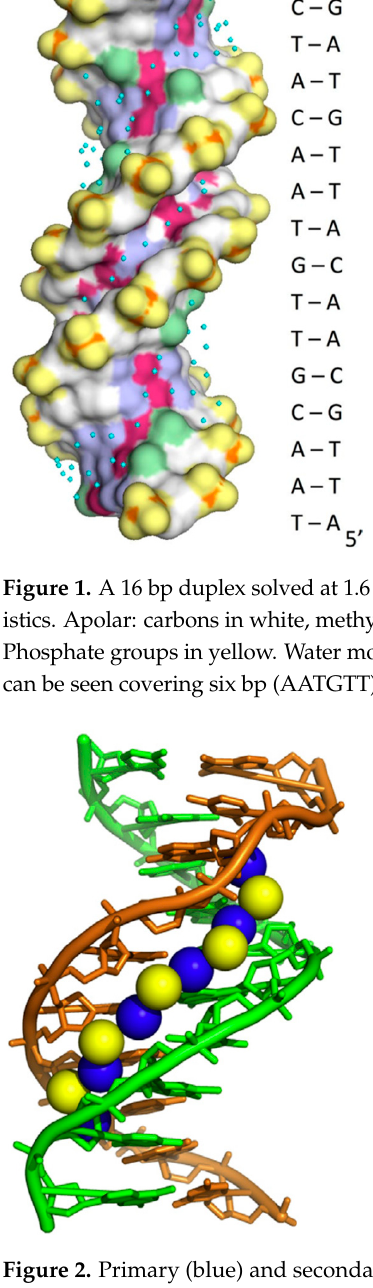
Figure 2. Primary (blue) and secondary (yellow) layers of the spine of water in the minor groove of the crosslinked dodecamer CGCGAATTCGCG. Diagram generated from the coordinates of NDB accession number BD0008 (Reprinted with permission from Ref. [10]. Copyright 2007 Elsevier).